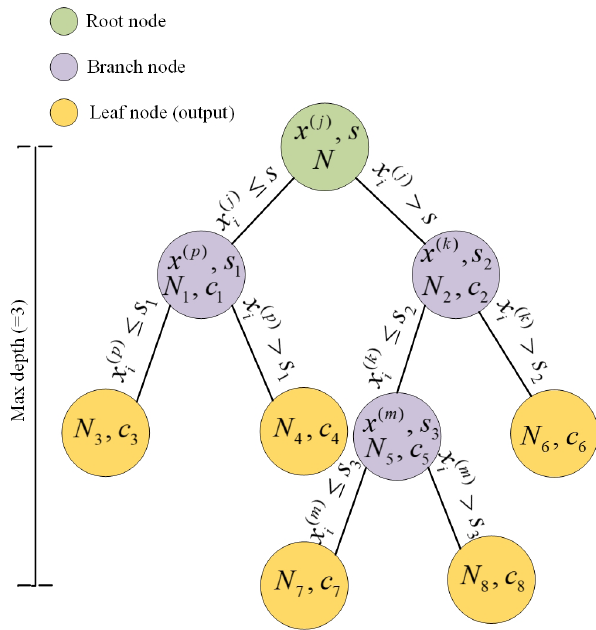
Figure 4. The structure of the decision tree